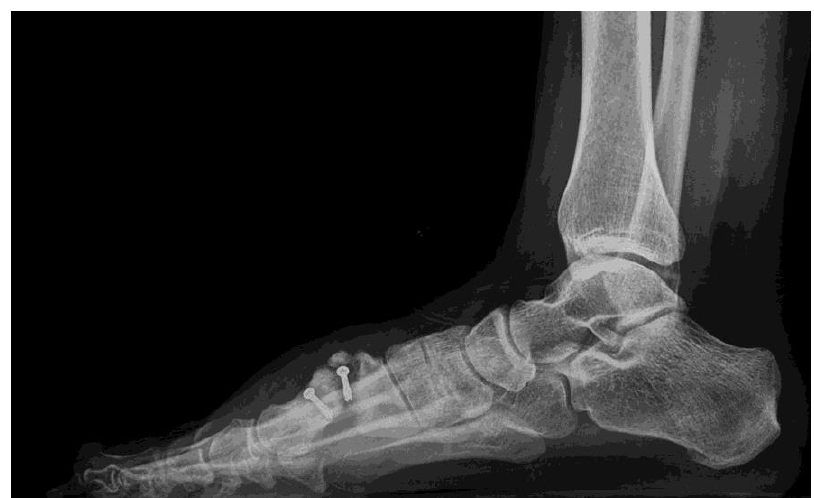
Figure 3. Rx Lateral immediately preoperative.